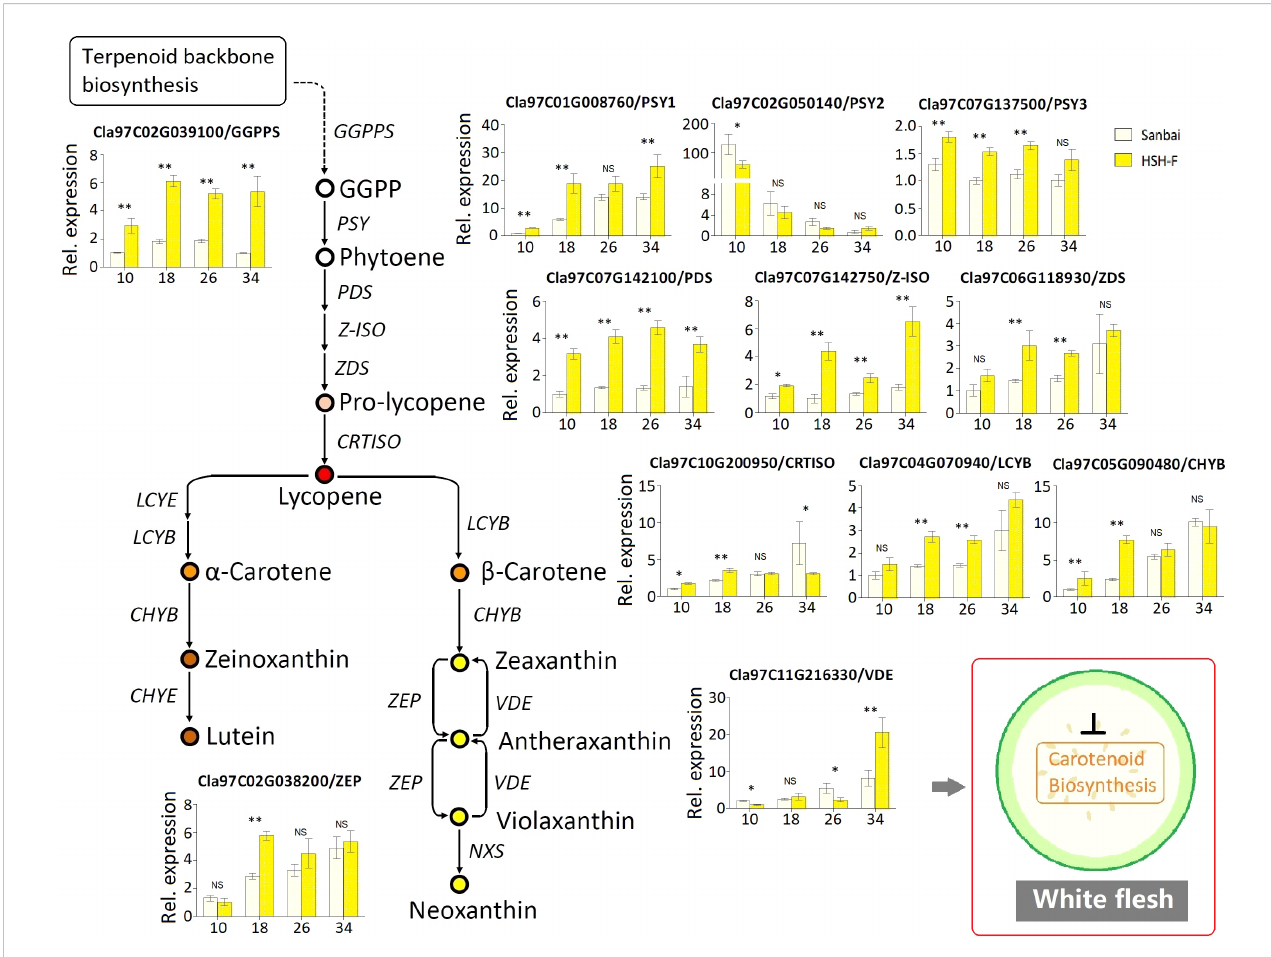
FIGURE 6 Relative expression of the carotenoid biosynthesis pathway genes in fruits of the canary yellow and white fl esh parents. Numbers on the x -axis — 10, 18, 26, and 34 — represent fruits at 10, 18, 26, and 34 days after pollination (DAP), respectively. PSY , phytoene synthase; GGPPS , geranylgeranyl pyrophosphate synthase; PDS , phytoene desaturase; Z-ISO , 15- cis - z -carotene isomerase; ZDS , z -carotene desaturase; CRTISO , lycopene isomerase; LCYB , lycopene b -cyclase; CHYB , carotenoid b -hydroxylase; ZEP , zeaxanthin epoxidase; VDE , violaxanthin de-epoxidase. Error bars indicate the mean ± SD ( n = 3). Signi fi cant difference between the two parents at each stage was assessed using Student ’ s t -test. * p < 0.05; ** p < 0.01. NS, no signi fi